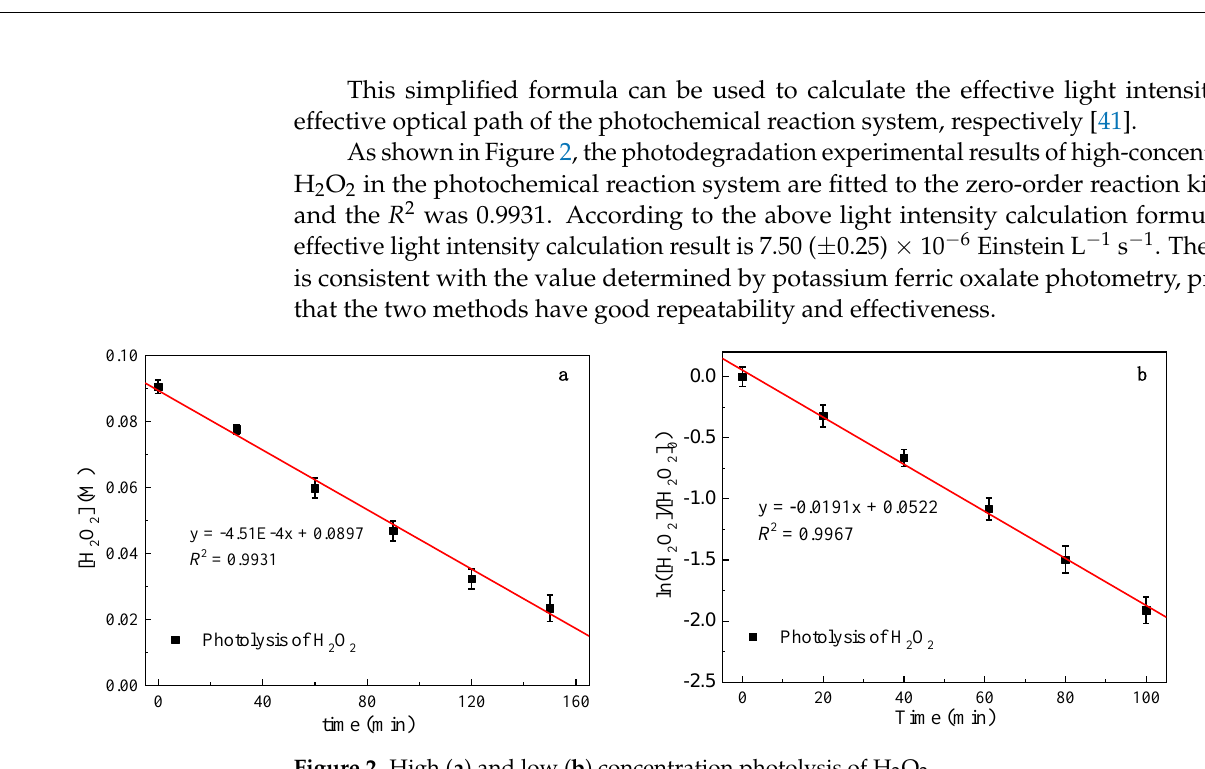
(Figure 2b), R 2 fitting the first-order reaction kinetics reaches 0.9967. The effective optical path was measured as 0.935 (±0.04) cm.